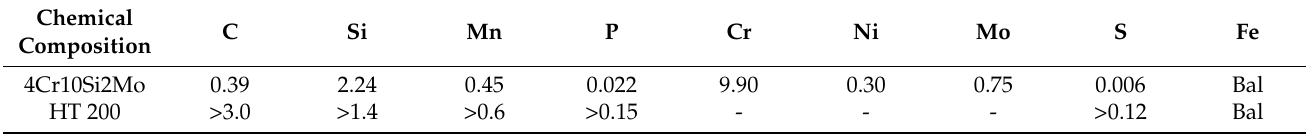
Table 1. The mass fractions of the chemical compositions of the upper and lower samples (mass fraction %).